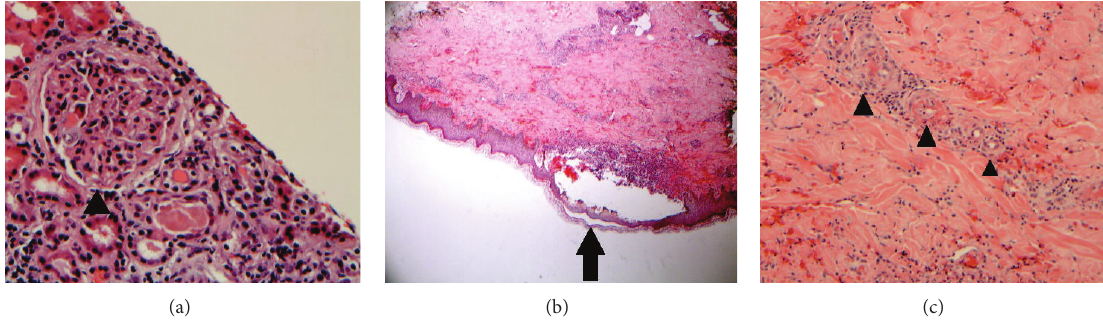
Figure 2: (a) Showing thickening of the glomerular capillary basement membrane (black arrow head). (b) Section of the skin demonstrates a neutrophil-rich subepidermal blister (black arrow) with (c) which shows leukocytoclastic vasculitis (black arrow heads) involving the blood vessels of the upper and deep